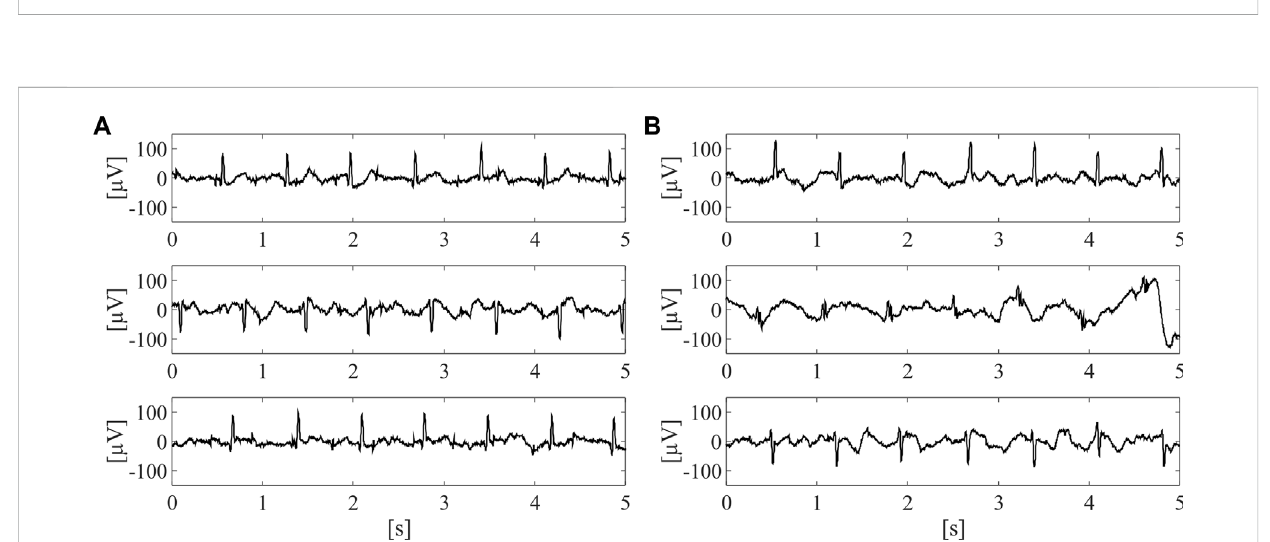
FIGURE 2 Examples of three informative (A) and three non-informative (B) 5-s segments included in the dataset adopted for SQA-based classi fi cation modelling, after preliminary pre-processing by 4th-order IIR Butterworth high-pass fi lter at 1